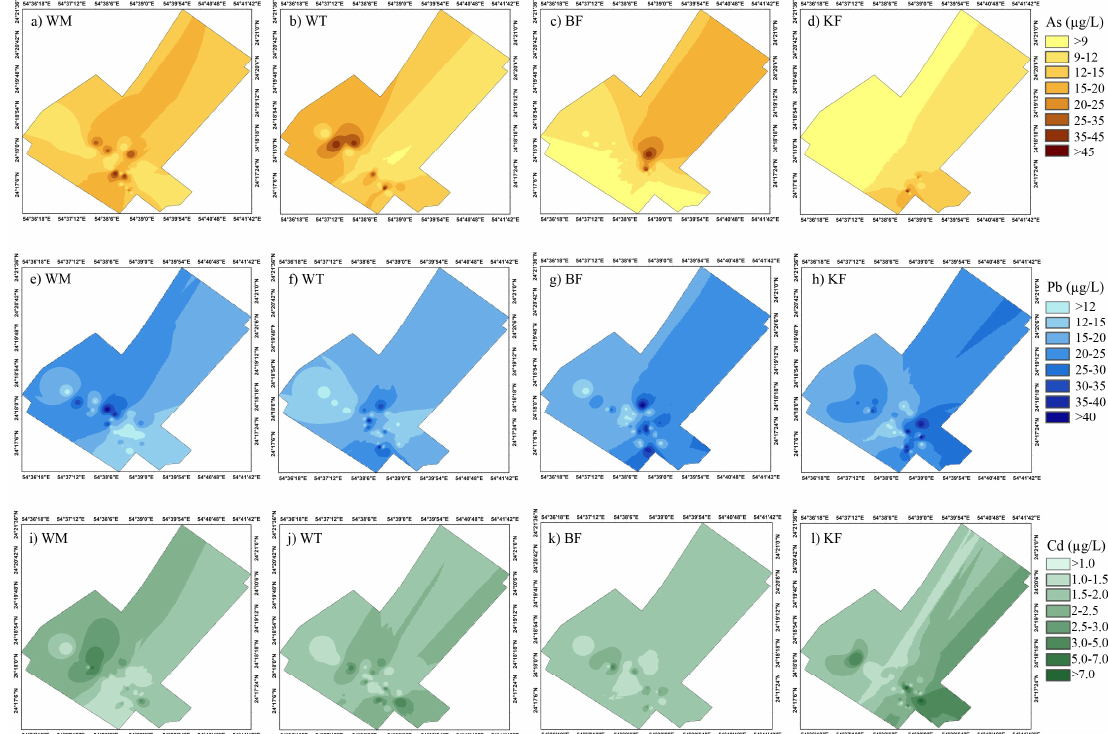
Figure 3. Spatial variation of heavy metals; ( a – d ) Arsenic concentrations for the four sampling points: water main (WM), water tank (WT), bathroom faucet (BF) and kitchen faucet (KF), respectively. ( e – h ) Lead concentrations for the four sampling points WM, WT, BF, and KF respectively. ( i – l ) Cadmium concentrations for the four sampling points WM, WT, BF, and KF